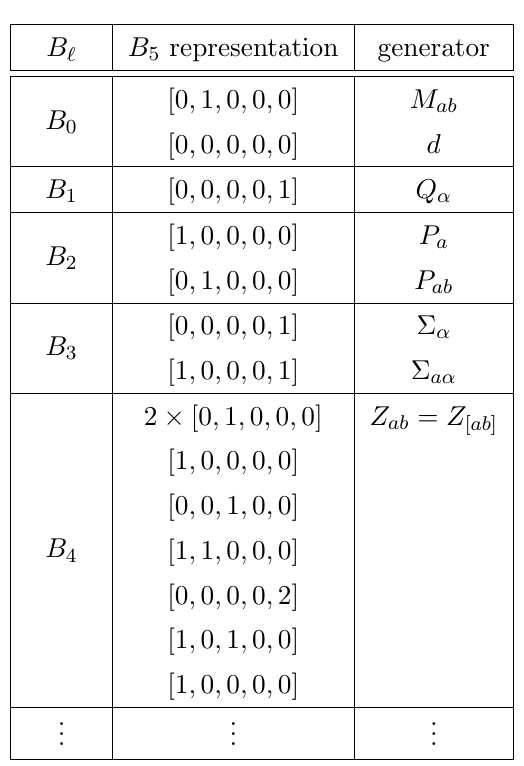
Figure 5 . Dynkin diagram of a Borcherds Lie superalgebra that is related to a quotient of the free Lie superalgebra of D = 11 supersymmetry.